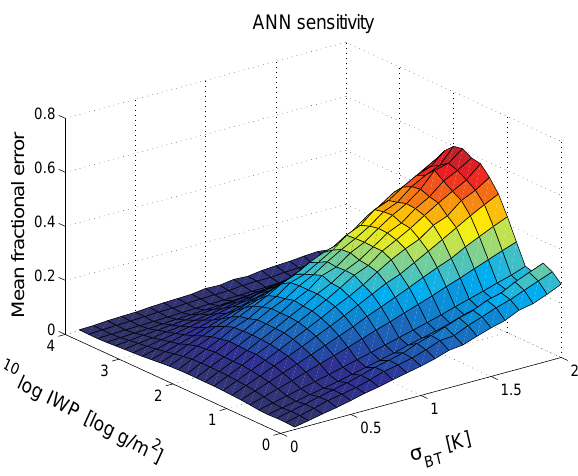
Fig. 13. Comparison of the median fractional error between in- dependent and retrieved IWP, when only MHS channels are used or when both MHS and HIRS channels are used as input to the ANN. The median fractional error is defined as the median of all errors with a certain IWP, where the error is defined as ˛ ˛ (cid:12) (cid:12) . ˛ ˛ IWP NN − IWP CPR (cid:12) (cid:12) ˛ ˛ (cid:12) (cid:12) IWP CPR (cid:12) (cid:12)